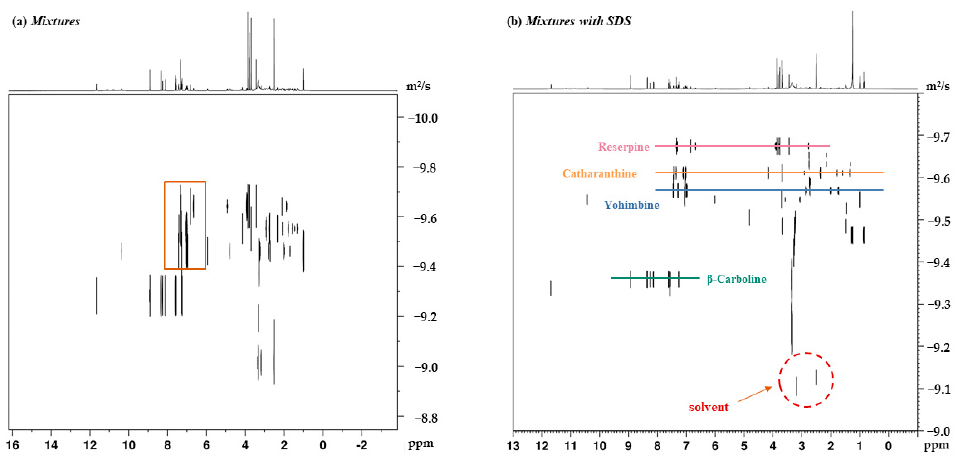
Figure 4. ( a ) DOSY spectrum of mixtures (each component was 2 mg) dissolved in 600 μ L of DMSO- d 6 . ( b ) DOSY spectrum of the same mixtures as in ( a ), but in the presence of 2 mg of SDS.